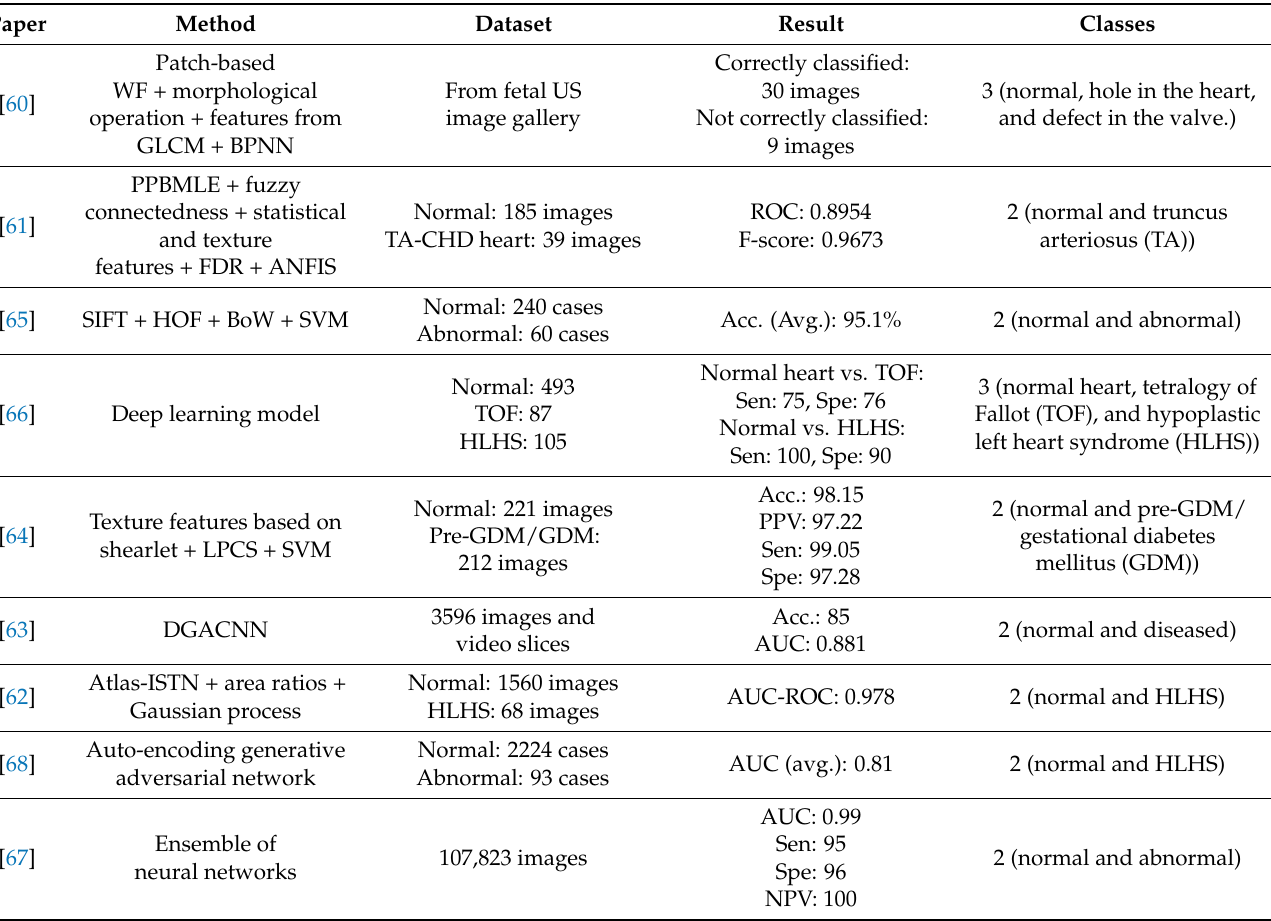
Table 3. State-of-the-art decision support systems using fetal heart ultrasound images and